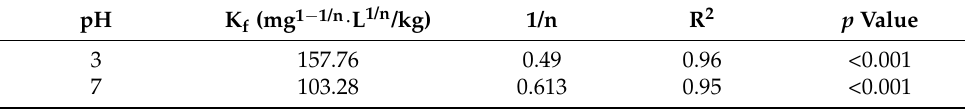
Table 4. Freundlich model for BPA on soil at different